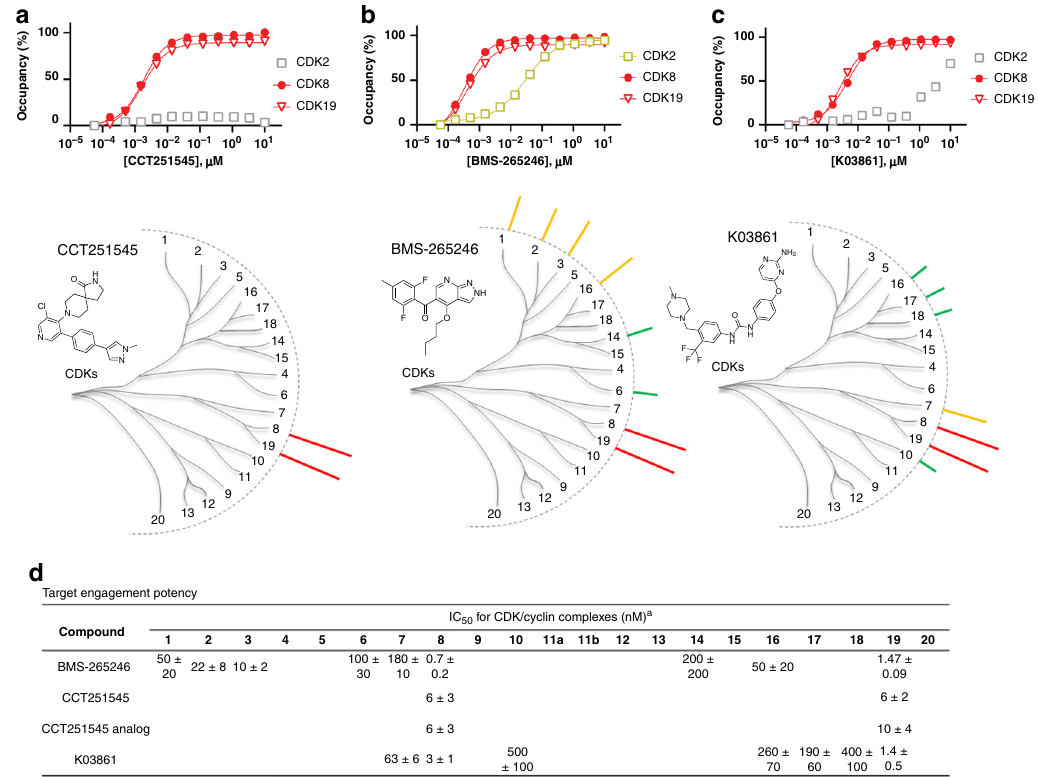
Fig. 4 Selective dual inhibitors of CDK8/19. Target engagement at CDK8/19 (upper panels) with compounds CCT251545 ( a ), BMS-265246 ( b ), and K03861 ( c ). CDK2 is included in each graph for comparative reference. Each graph shows a single representative technical replicate ( n = 1) from 3 independent experiments (Supplementary Data 2). Lower: Compound structures and dendrogram-based illustration of engagement selectivity for CCT251545, BMS-265246, and K03861 against the complete CDK family D. Representative live cell engagement potency for CDK8/19-selective compounds. Reported IC 50 data are the mean of 3 independent experiments ± S.E.M. (Supplementary Data 2). Blank cells represent IC 50 values that failed to meet our criteria of potency (<1 µ M) or occupancy ( ≥ 50% at 10 µ M). Source data are provided as a Source Data fi